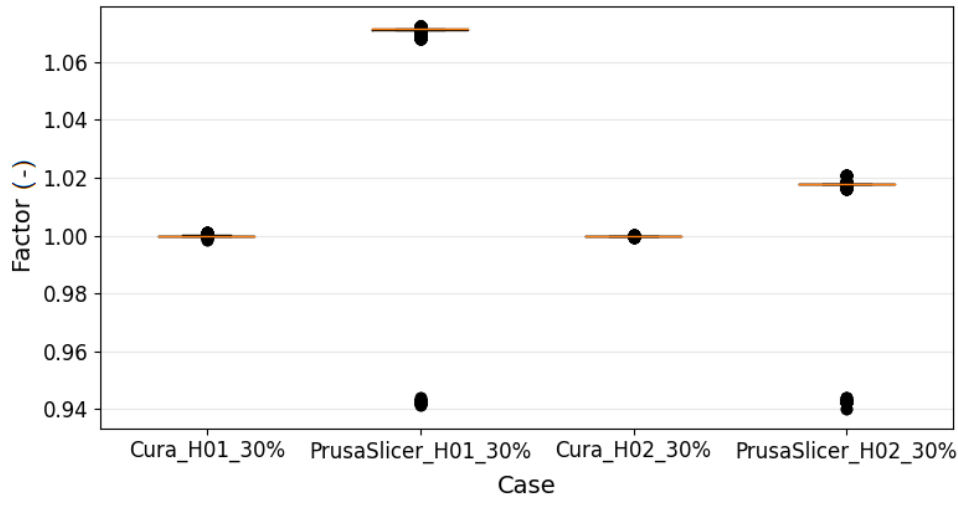
Figure 8. Volumetric fill for the